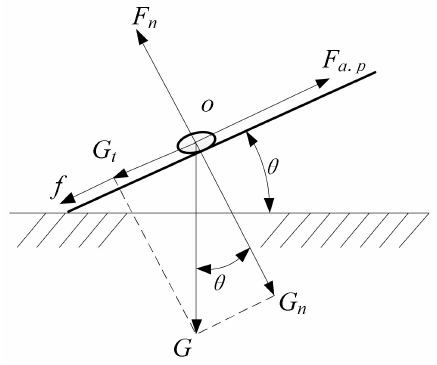
Figure 5. Force diagram of jujube fruit on the provoke